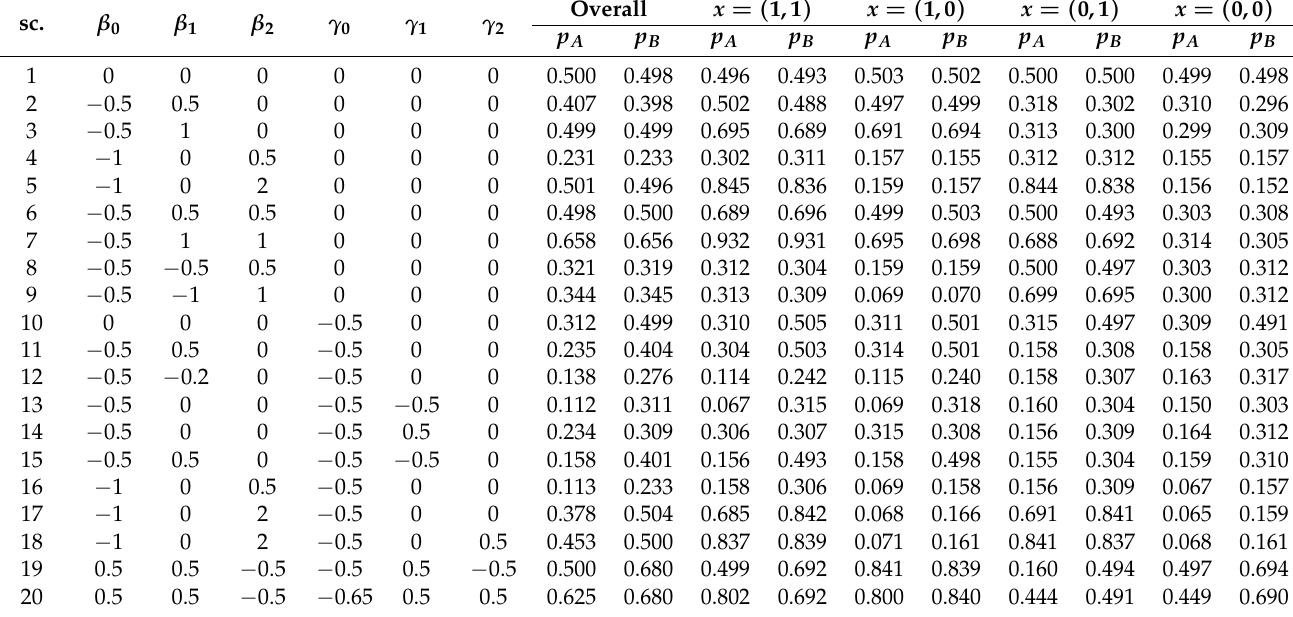
Table 1. Simulation scenarios: True model parameters when x 1 and x 2 are independently generated from a Bernoulli distribution with response probability 0.5. Note that “sc” denotes scenarios.